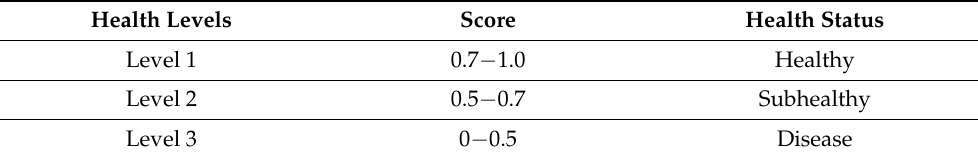
Table 2. Subsystem health classification.